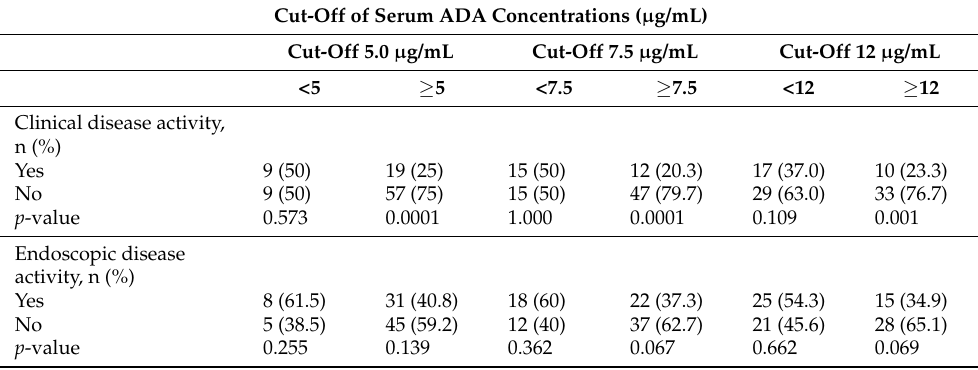
Table 3. Clinical and endoscopic disease activity according to different cut-off values of ADA se- rum concentrations.